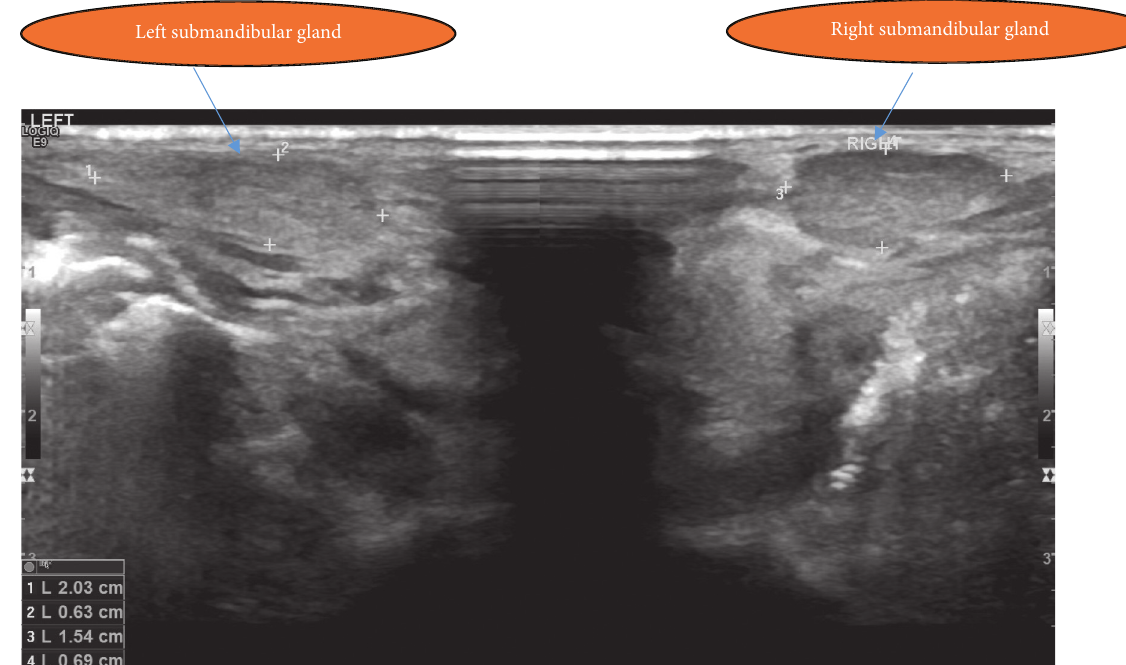
Figure 3: Ultrasound with bilateral submandibular gland enlargement (hypoechoic area).